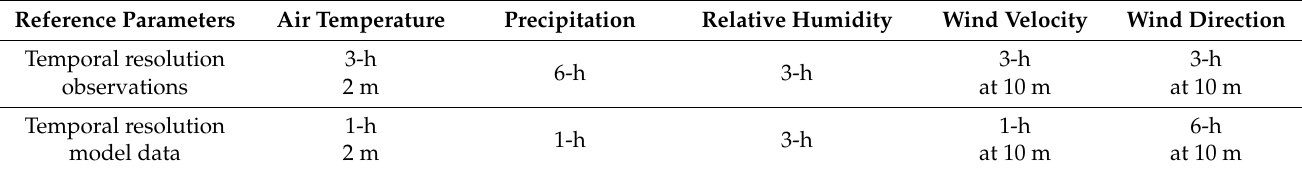
Table 2. Overview of meteorological parameters and time resolution for observations and model data. Reference